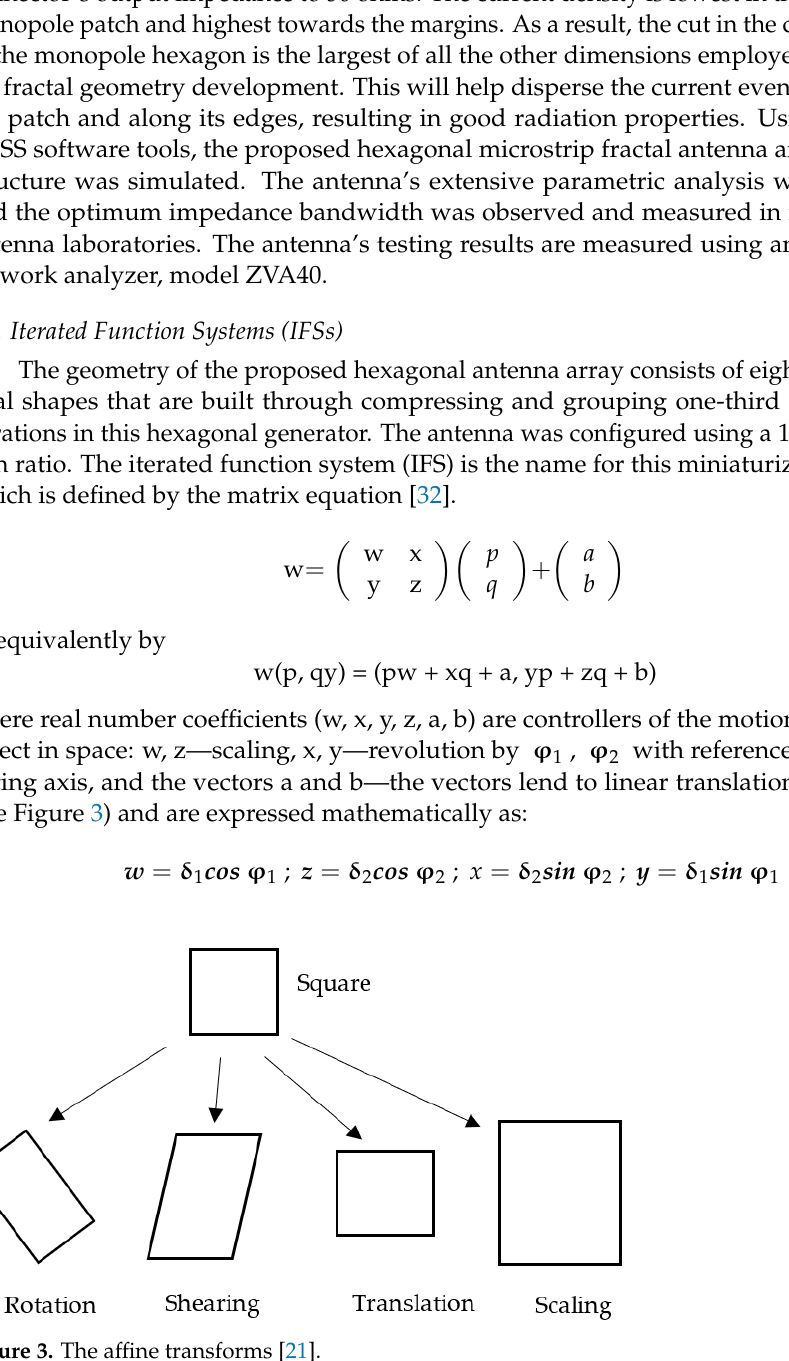
Figure 3. The affine transforms